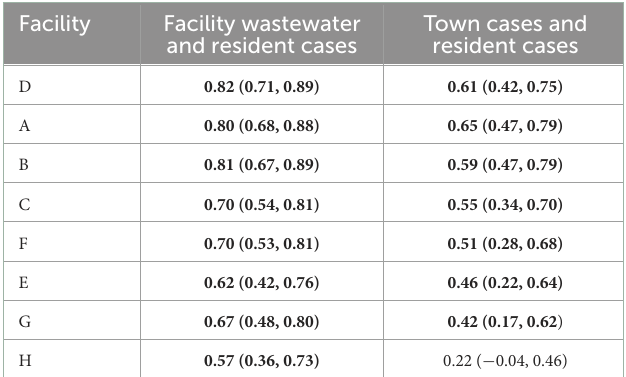
TABLE 2 Table of Spearman’s rank correlation coefficients by Massachusetts Department of Corrections facility for facility wastewater, resident active COVID-19 cases, and town COVID-19 cases, December 2020–February